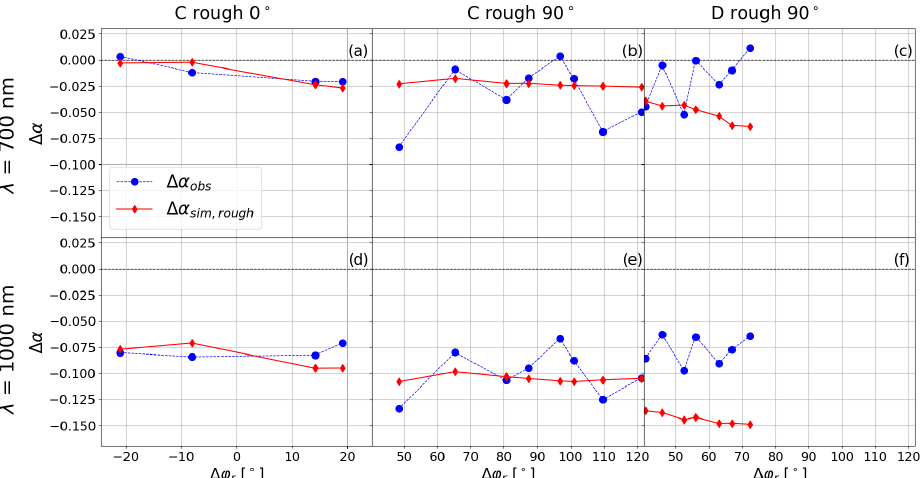
Figure 8. Measured and simulated variations in (cid:49)α ([rough–smooth] at the same θ s ) at 700nm as a function of (cid:49)ϕ r for (a) the C rough 0 ◦ experiment, (b) the C rough 90 ◦ experiment and (c) the D rough 90 ◦ experiment. (d) , (e) and (f) are the same but at 1000nm. Blue points are (cid:49)α obs , and red lines with diamonds are (cid:49)α sim , rough . The horizontal black dashed lines show